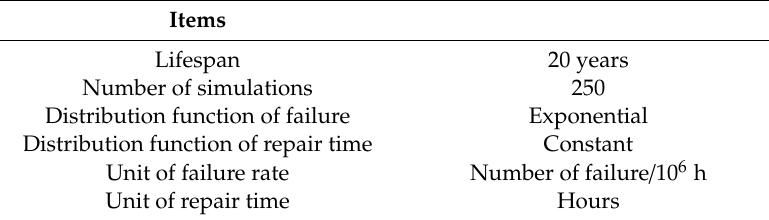
Table 1. Operation conditions and assumption.